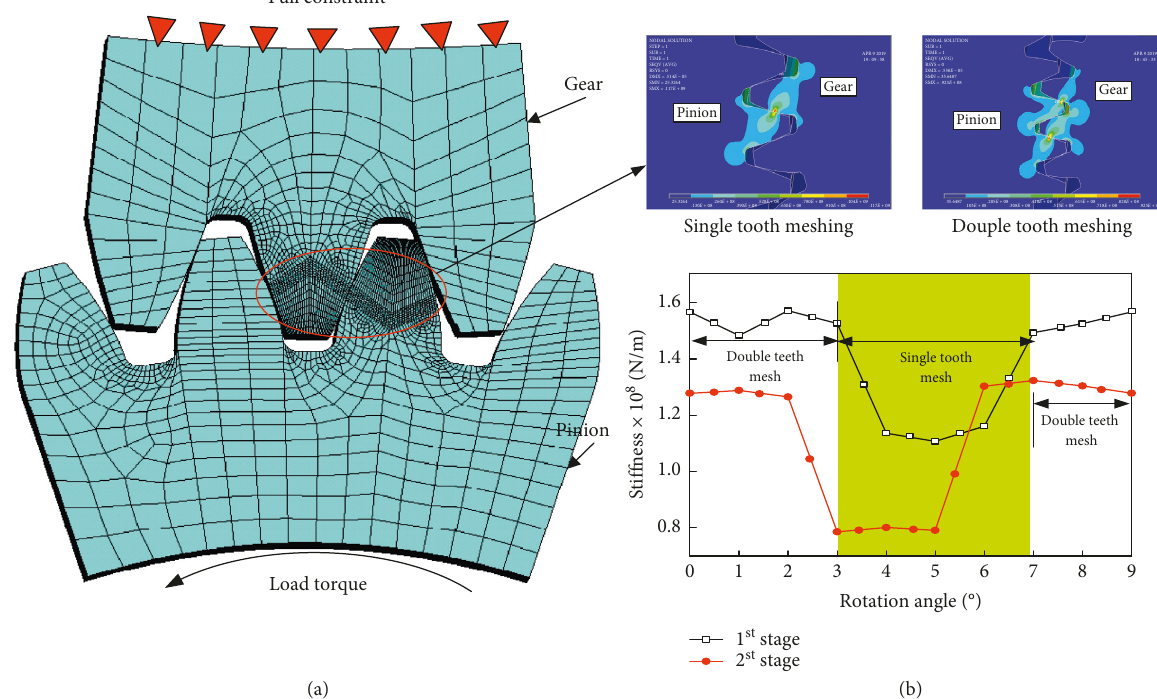
Figure 5: Solution of time-varying mesh stiffness. (a) FE analysis model of gear pair. (b) Meshing stiffness